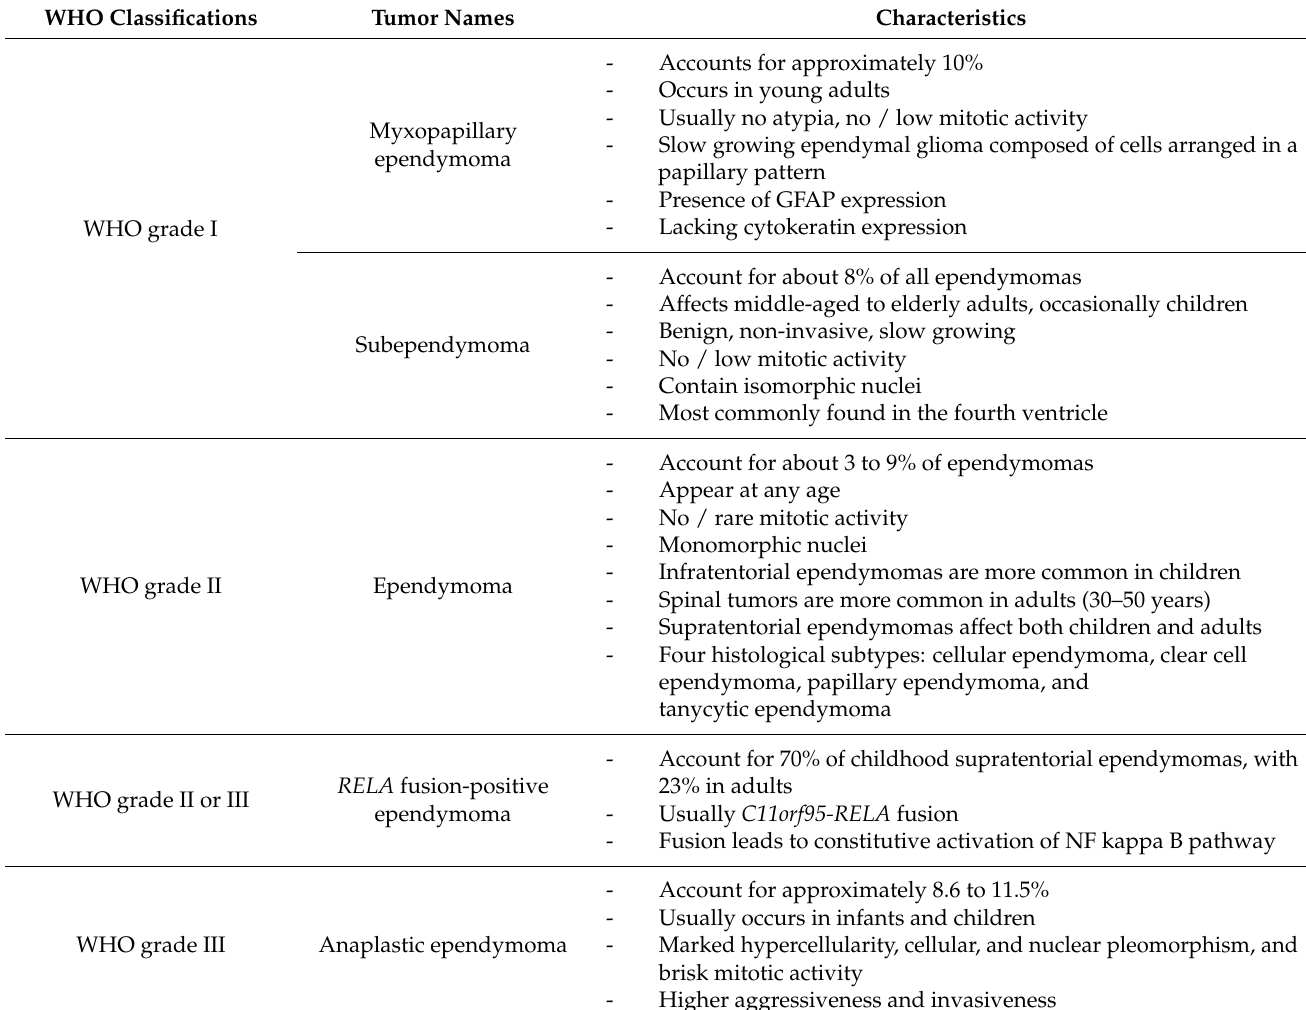
Table 1. Classification and histopathological features of ependymomas that are provided by World Health Organization 2016